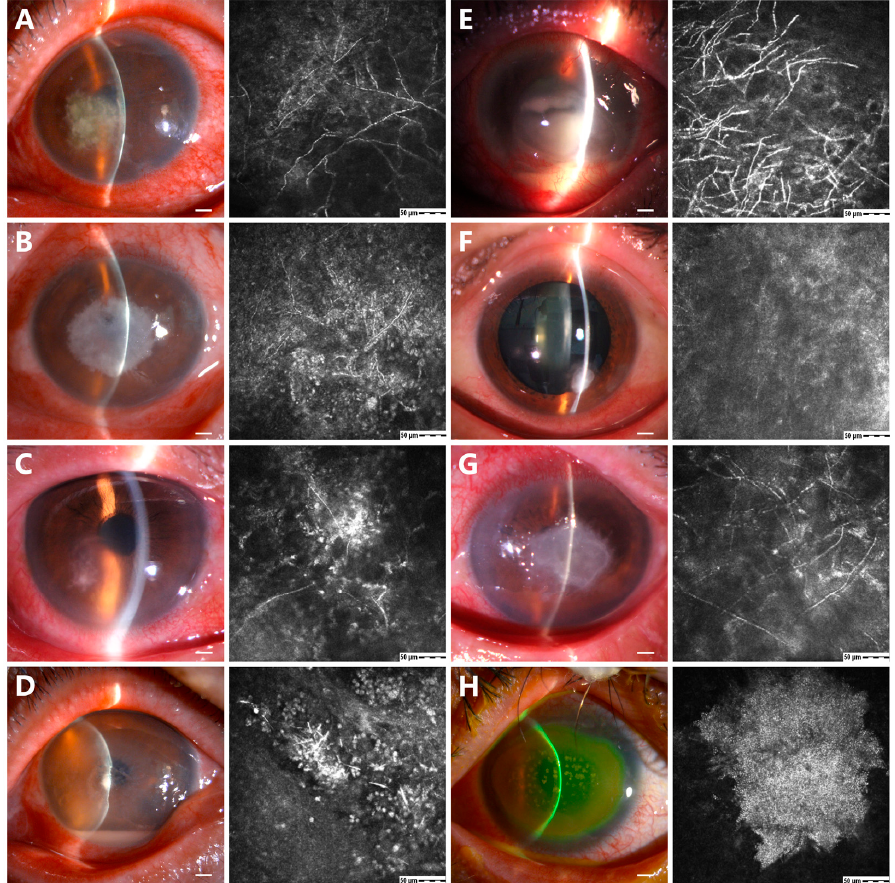
Figure 3. In vivo confocal microscopy (IVCM) images of patients with FK. ( A ) Fusarium shows a large number of highly reflective lines, 374.3 ± 49.2 µ m in length, 9.4 ± 2.3 µ m in width, branching at 45.4 ± 7.8 degrees. ( B ) Aspergillus shows numerous high-contrast lines, 262.8 ± 20.6 µ m in length and 11.7 ± 2.7 µ m in width, with branches at 52.1 ± 5.5 degrees. ( C ) Alternaria shows many hyperreflective hyphae, 7.9 ± 1.8 µ m in width and 130.7 ± 45.7 µ m in length, with branching at 39.5 ± 3.7 degrees. ( D ) Curvularia shows short and thick hyphae structures, 12.5 ± 1.8 µ m in width and 37.3 ± 8.6 µ m in length without apparent fungal branching. ( E ) Pseudallescheria boydii shows hyper-reflective, branching hyphae, 7.8 ± 1.7 µ m in width and 217.3 ± 56.5 µ m in length, with the angle of fungal branching at 48.2 ± 6.0 degrees. ( F ) Paecilomyces lilacinus shows linear structures, dichotomous branching hyphae, 6.3 ± 2.2 µ m in width and 71.2 ± 22.9 µ m in length, with the angle of fungal branching at 63.7 ± 17.2 degrees. ( G ) Exserohilum shows numerous large septate hyphae, 8.0 ± 1.6 µ m in width and 320.2 ± 50.6 µ m in length, with the angle of fungal branching at 82.1 ± 7.2 degrees. ( H ) Candida shows numerous elongated particles, coral-like, and without branching. (Scale bars = 1 mm in slit lamp; 50 µ m in confocal microscopic